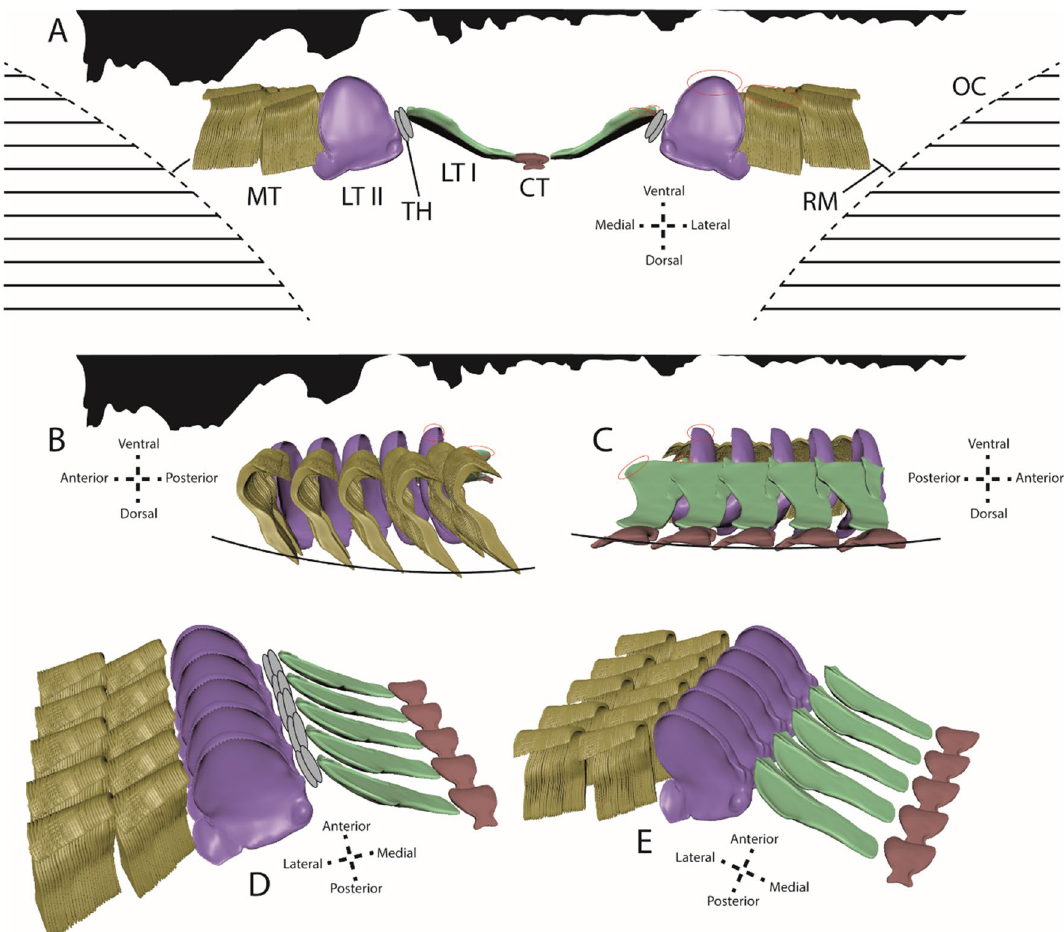
Figure 9. Visualization of proposed position of teeth on radular membrane during foraging, between the two odontophoral cartilages, from different views (see axes for anatomical orientation). Silhouettes (drawn with Adobe Illustrator CS 6) of sandpapers used (from left to right: rough, medium, fine) in ( A – C ) are scaled identically to dimensions of teeth. Contact areas are highlighted in red. ( A ) Frontal view depicting the inverse w-shape of membrane. ( B – C ) Lateral and medial views depicting additionally a curvature of the membrane towards dorsal. ( D – E ) Curvature from latero-ventral and medio-ventral view. CT = central tooth, LTI = lateral tooth I, LTII = lateral tooth II, MT = marginal teeth, OC = odontophoral cartilage, RM = radular membrane, TH = thickening of membrane/ interlocking